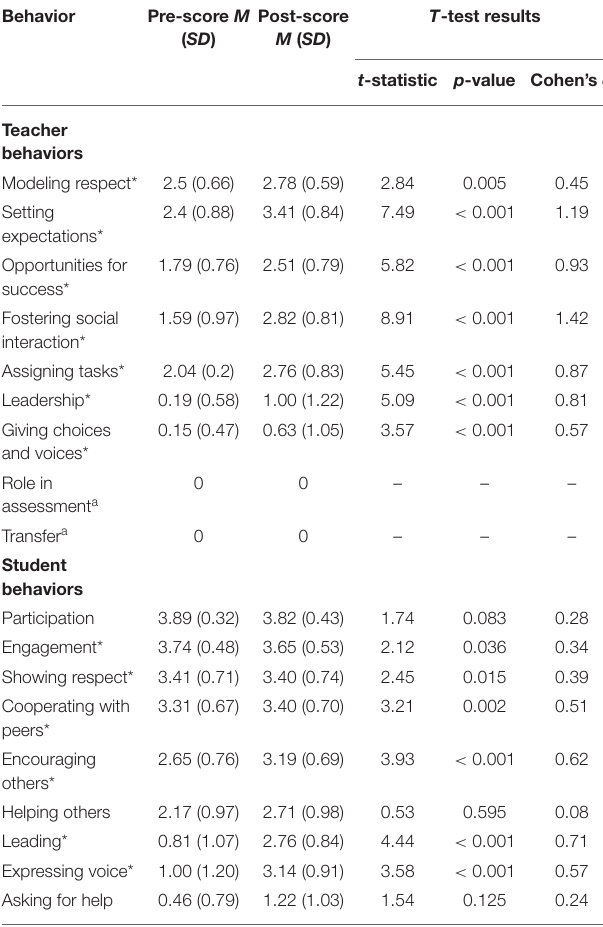
TABLE 1 | Pre- and post-TARE 2.0 ratings of teacher and student behaviors for the intervention teacher.